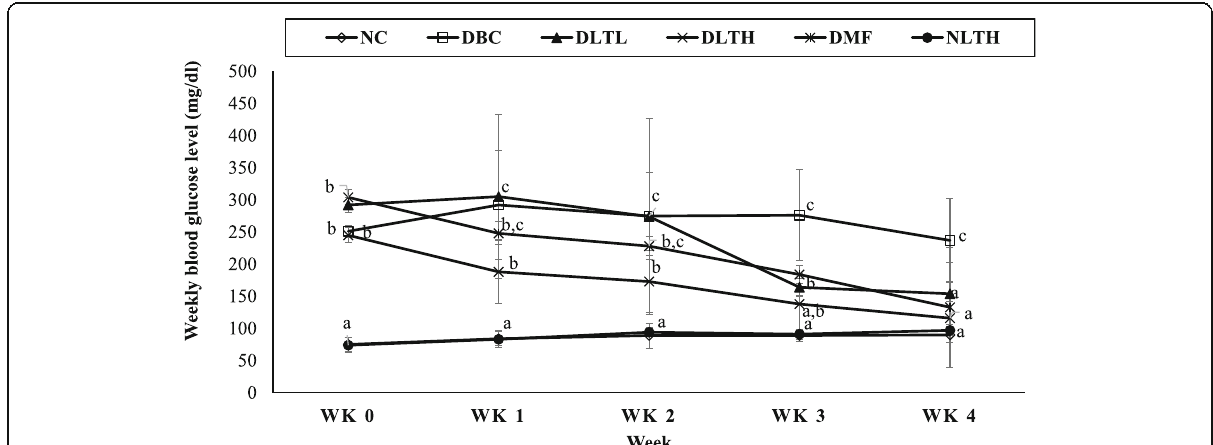
Fig. 3 Weekly blood glucose levels of different animal groups during the experimental period. Data are presented as the mean ± SD of 7 animals. a – c Values with different letters over the bars for a given parameter are significantly different from each other group of animals (Tukey ’ s-HSD multiple range post hoc test, p < 0.05). NC- Normal control; DBC- Diabetic control; DLTL- Diabetic lemongrass tea low; DLTH- Diabetic lemongrass tea high; DMF- Diabetic metformin; NLTH- Normal lemongrass tea